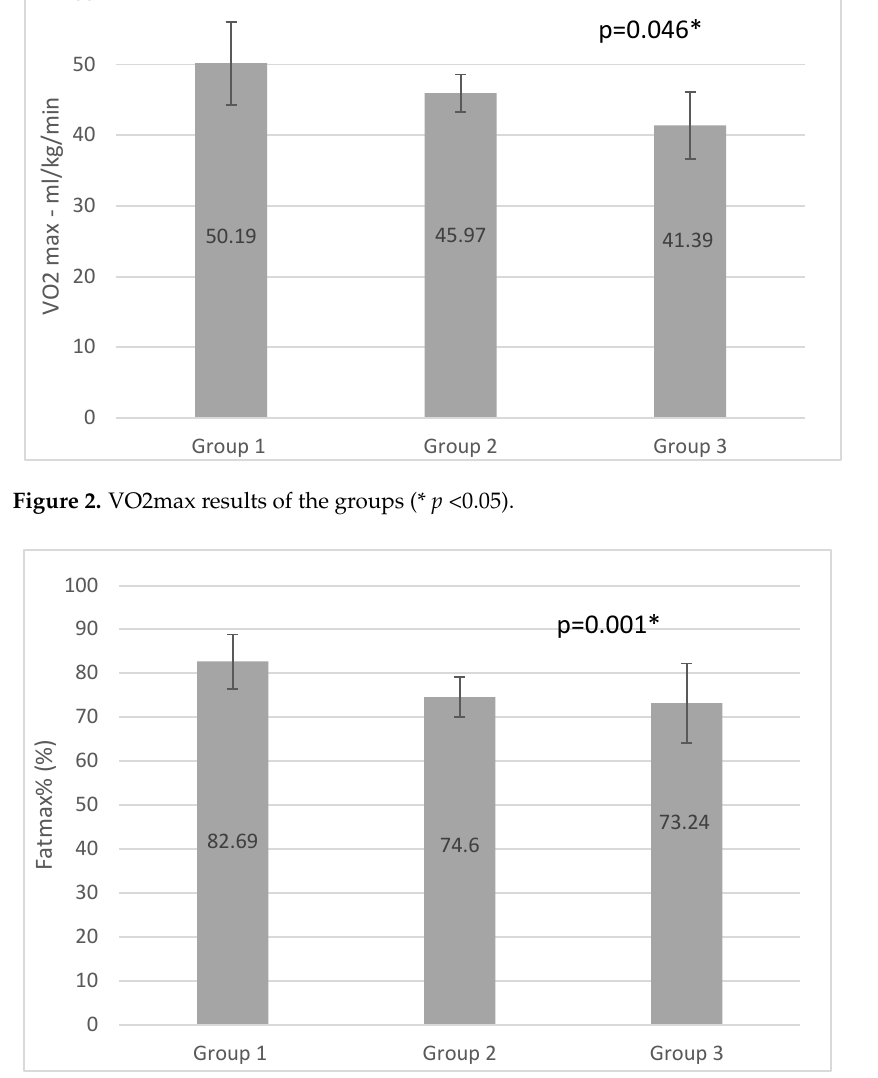
Figure 3. Fatmax% results of the groups (* p <0.05).